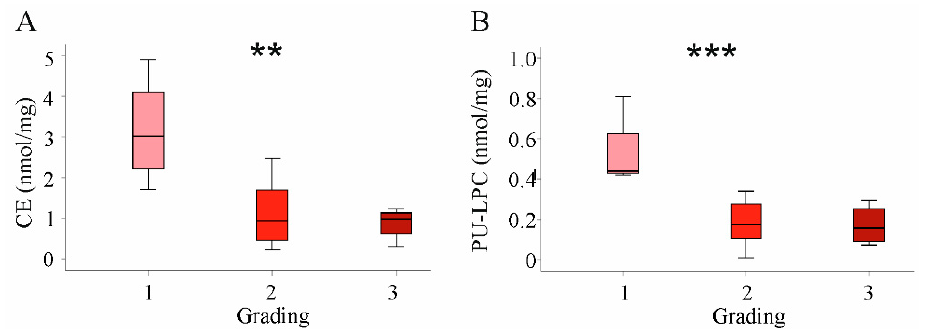
Figure 6. Association of cholesteryl ester (CE) and polyunsaturated lysophosphatidylcholine (PU- LPC) with tumor grading in the whole cohort. ( A ) CE levels and ( B ) PU-LPC levels in HCC tissues stratified for tumor grading. ** p < 0.01, *** p < 0.001 (One-way ANOVA).